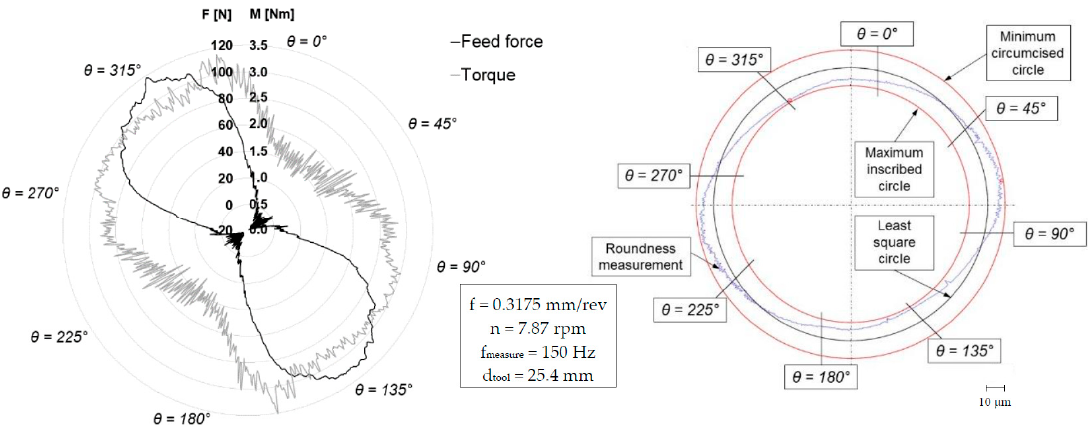
Figure 3. Cutting forces and torque graphs of tool 3 compared to the circularity of the machined hole.